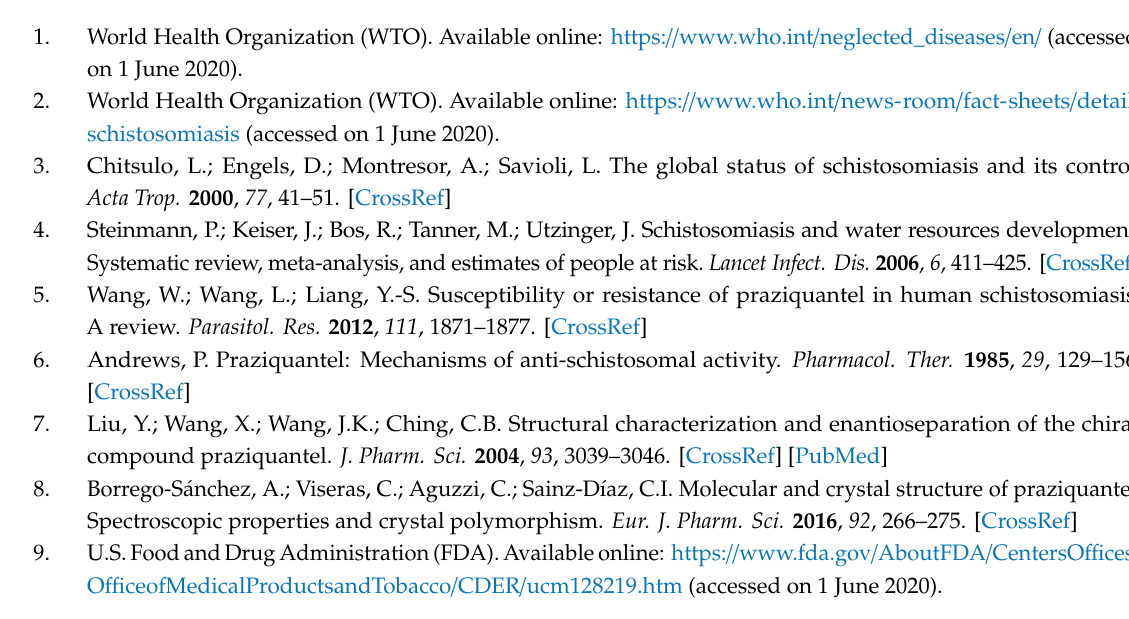
Table S1: Statistical parameters corresponding to the fittings of all the experimental release results of PZQ and PZQ–SEP interaction products to the equations of distinct models, Table S2: Statistical parameters corresponding to the fittings of all the experimental release results of PZQ and PZQ–VHS interaction products to the equations of distinct